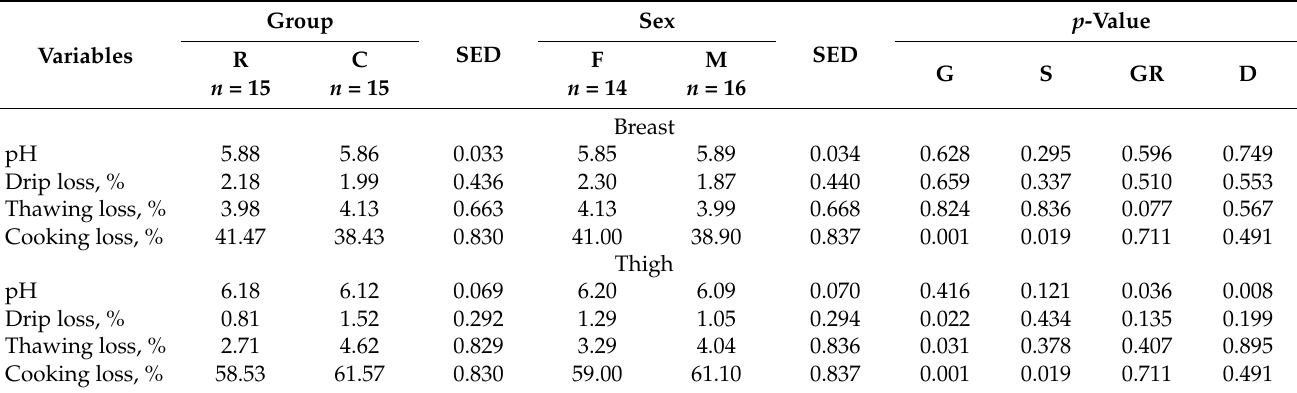
Table 4. Effects of diet and sex on goose meat pH and moisture loss.